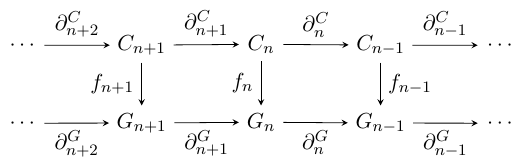
Figure 2 . A con(cid:12)guration f 2 hom( C; G ) 0 , consisting on a collection of homomorphisms f f n g